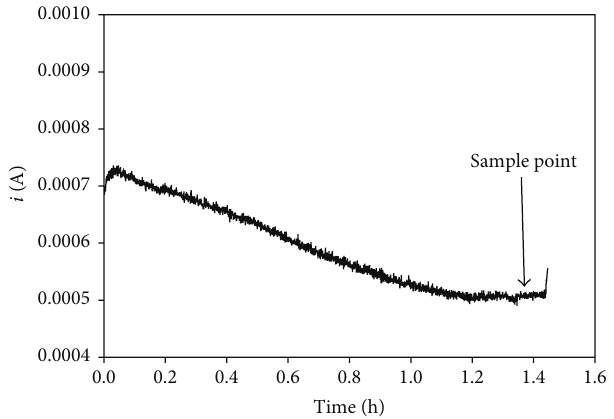
Figure 7: The current versus time: 0.2 mM Co(TPP)Cl in the presence of CO 2 and 0.28 M CF 3 CH 2 OH in MeCN − 5% DMF containing 0.1 M [Bu 4 N][BF 4 ], at carbon